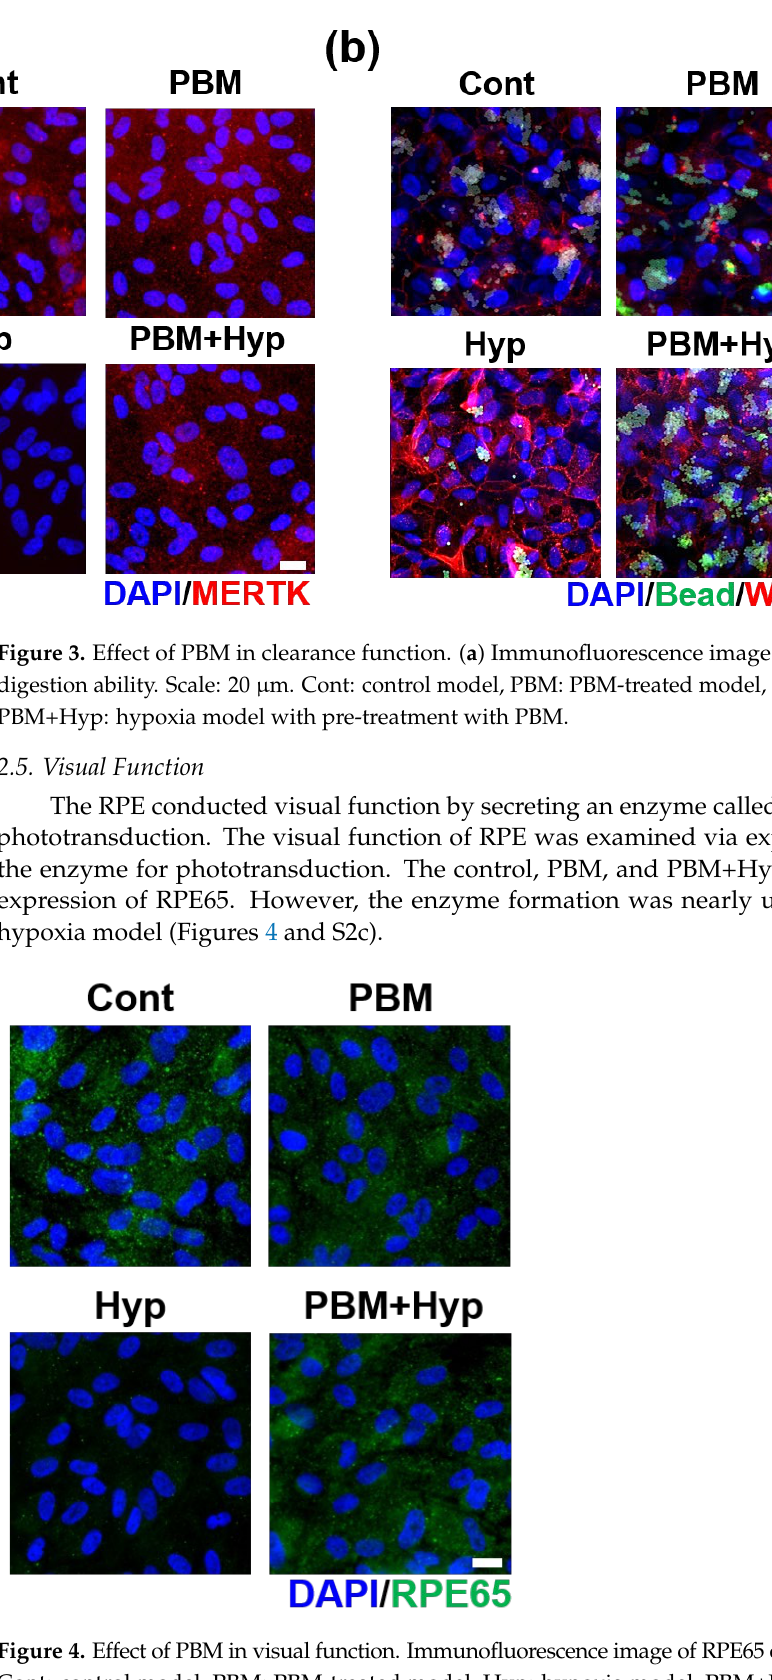
Figure 4. Effect of PBM in visual function. Immunofluorescence image of RPE65 enzyme. Scale: 20 μm. Cont: control model, PBM: PBM-treated model, Hyp: hypoxia model, PBM+Hyp: hypoxia model with pre-treatment with PBM.